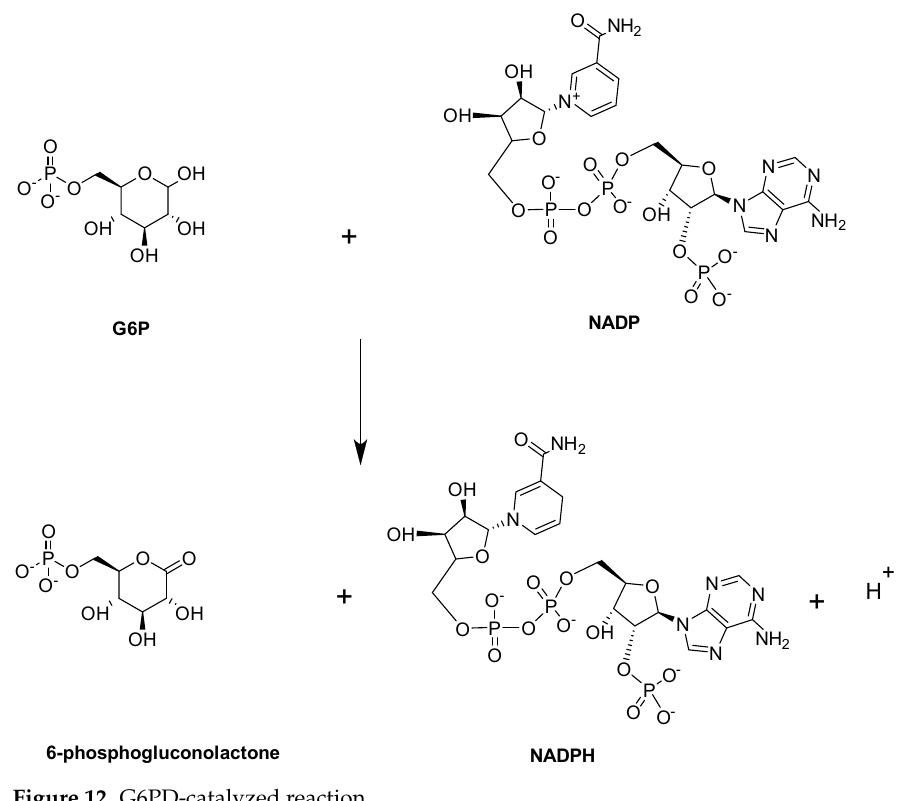
Figure 12. G6PD-catalyzed reaction.